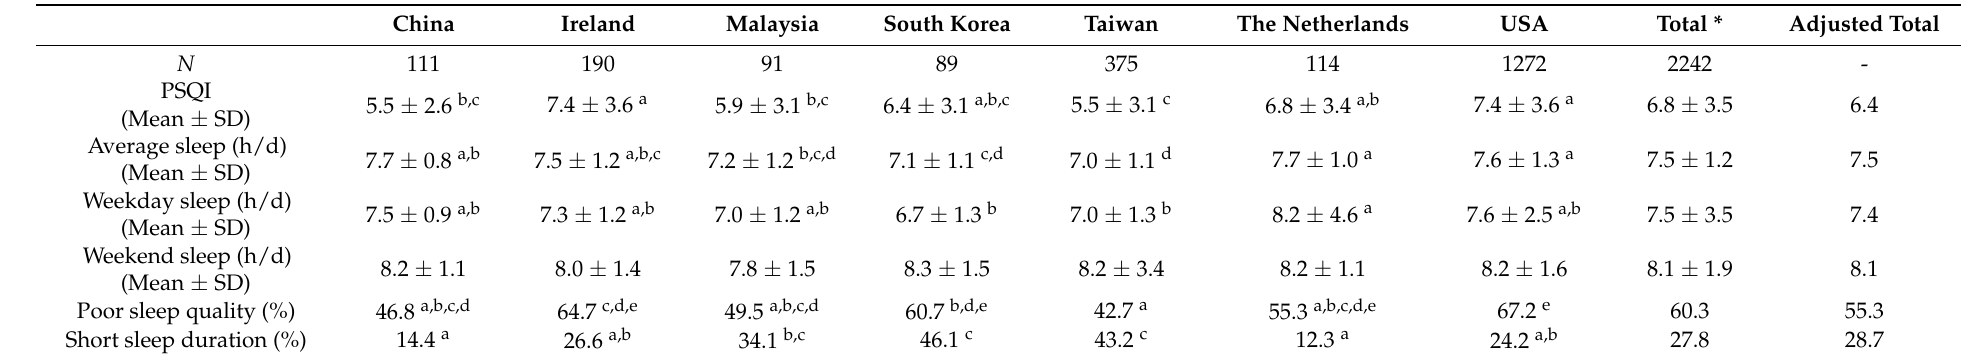
Table 2. Country comparisons of sleep quality and